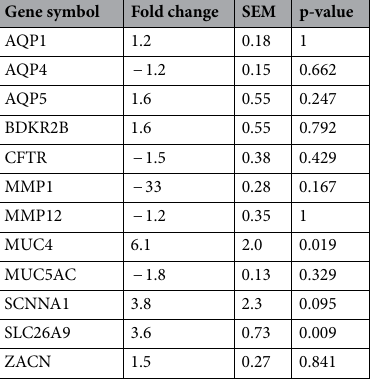
Gene symbol Fold change SEM